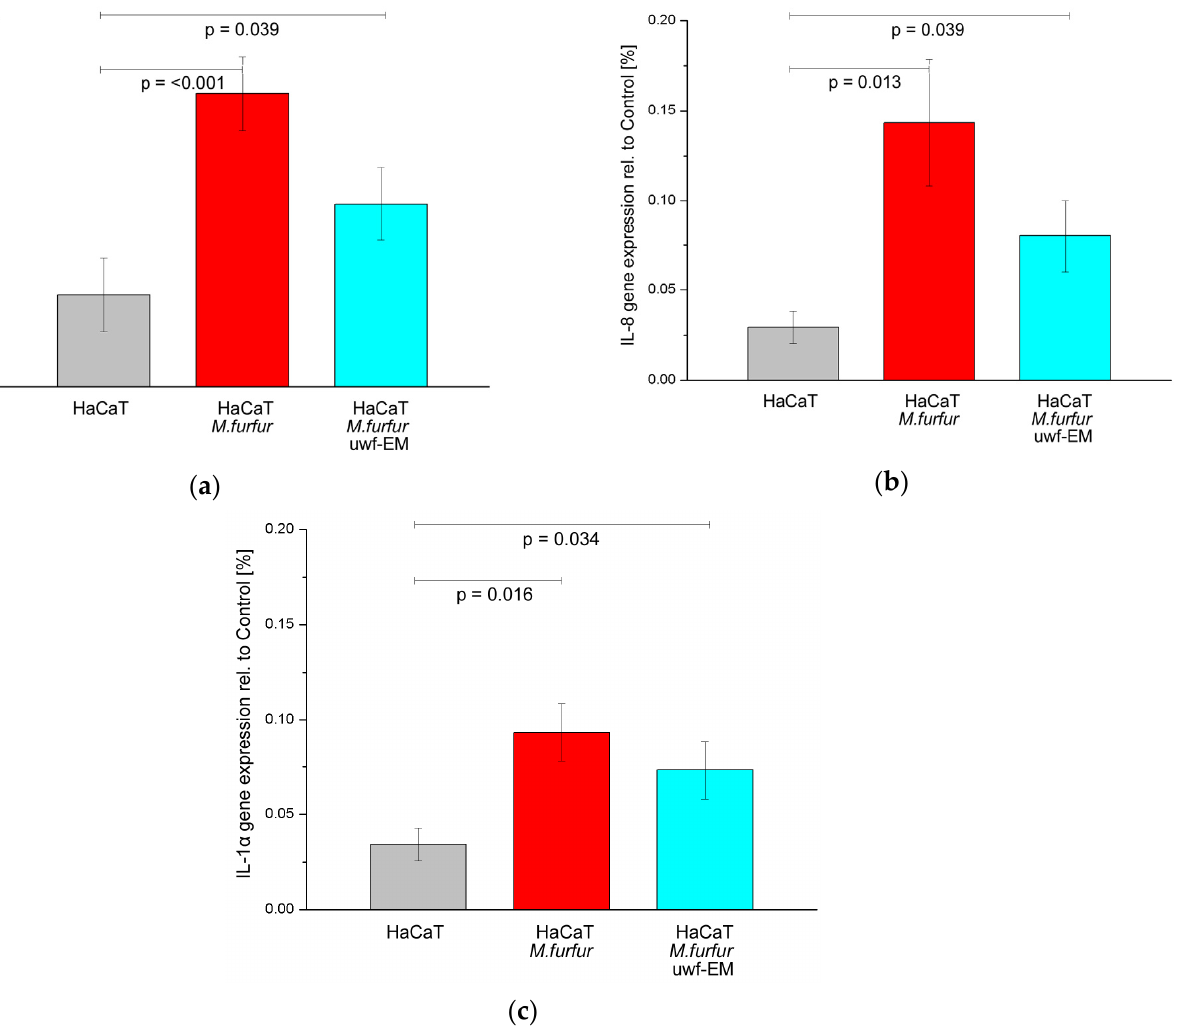
Figure 3. Gene expression of IL-6 ( a ), IL-8 ( b ), and IL-1 α ( c ) of HaCaT cell cultures after 24 h of incubation. The figure depicts the control (grey), the batch infected with M. furfur (red), and the batch infected with pre-treated M. furfur that underwent uwf-EM exposure (blue). For further details, see the Methods section. The calculated p -values ( p < 0.05) highlight the statistical significance of the obtained results. Table 3. Numeric representation of pro-inflammatory cytokines compared to the control as averages of three replicates along with the corresponding standard deviations.